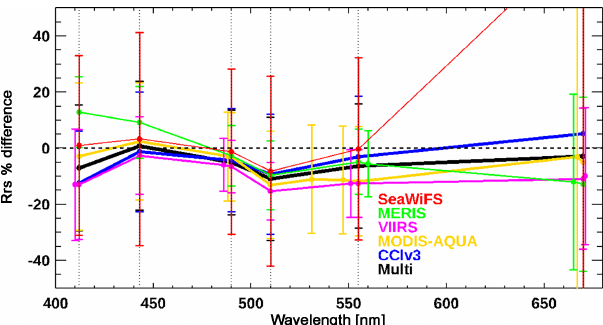
Figure 7. Relative difference between satellite and MedBiOp Rrs spectra for MODIS Aqua (yellow), NPP-VIIRS (magenta), Sea- WiFS (red), MERIS (green), OC-CCI (blue), and the multi-sensor product developed and described in this work (black). Vertical bars represent 1 standard deviation from the average RPD value. Target wavelengths are marked with vertical dotted